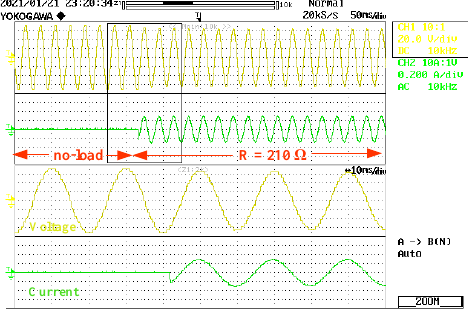
Figure 11. Load change from no-load to 210 Ω.